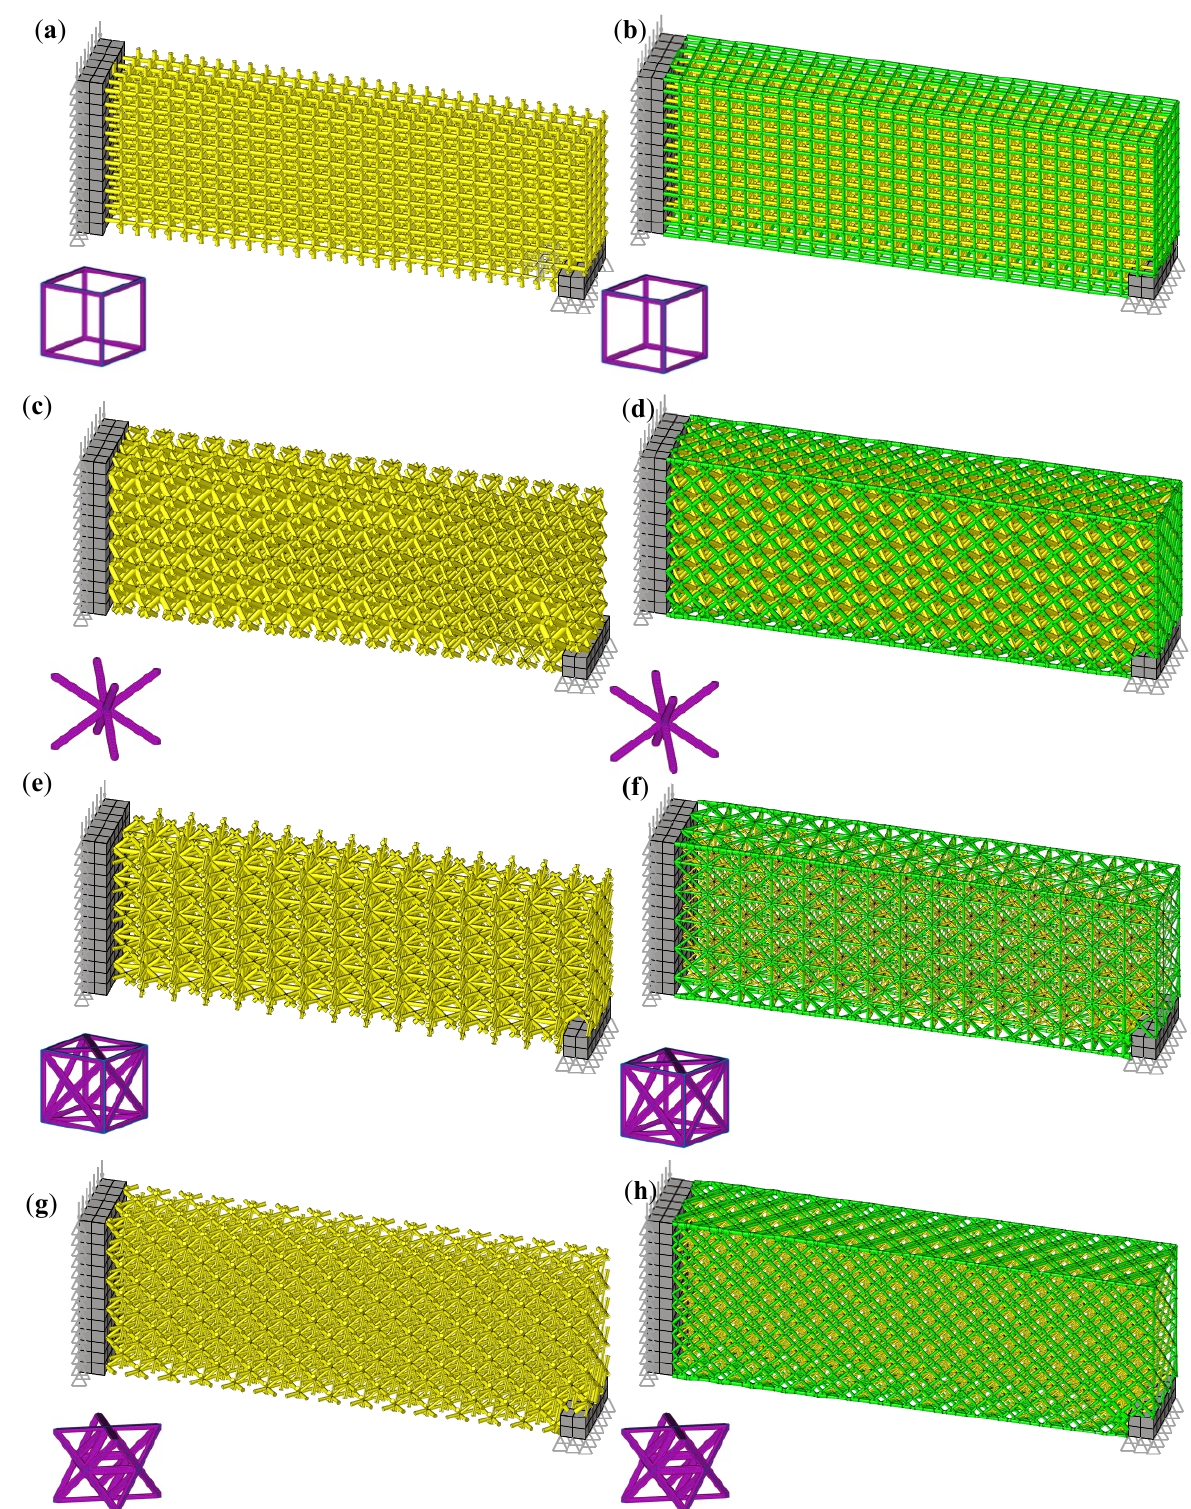
Figure 15. Optimized results (yellow = trimmed interior lattice, green = lattice net, purple = single unit cell): ( a ) Cubic without net. ( b ) Cubic with net. ( c ) BCC without net. ( d ) BCC with net. ( e ) FCC without net. ( f ) FCC with net. ( g ) Octet truss without net. ( h ) Octet truss with net.